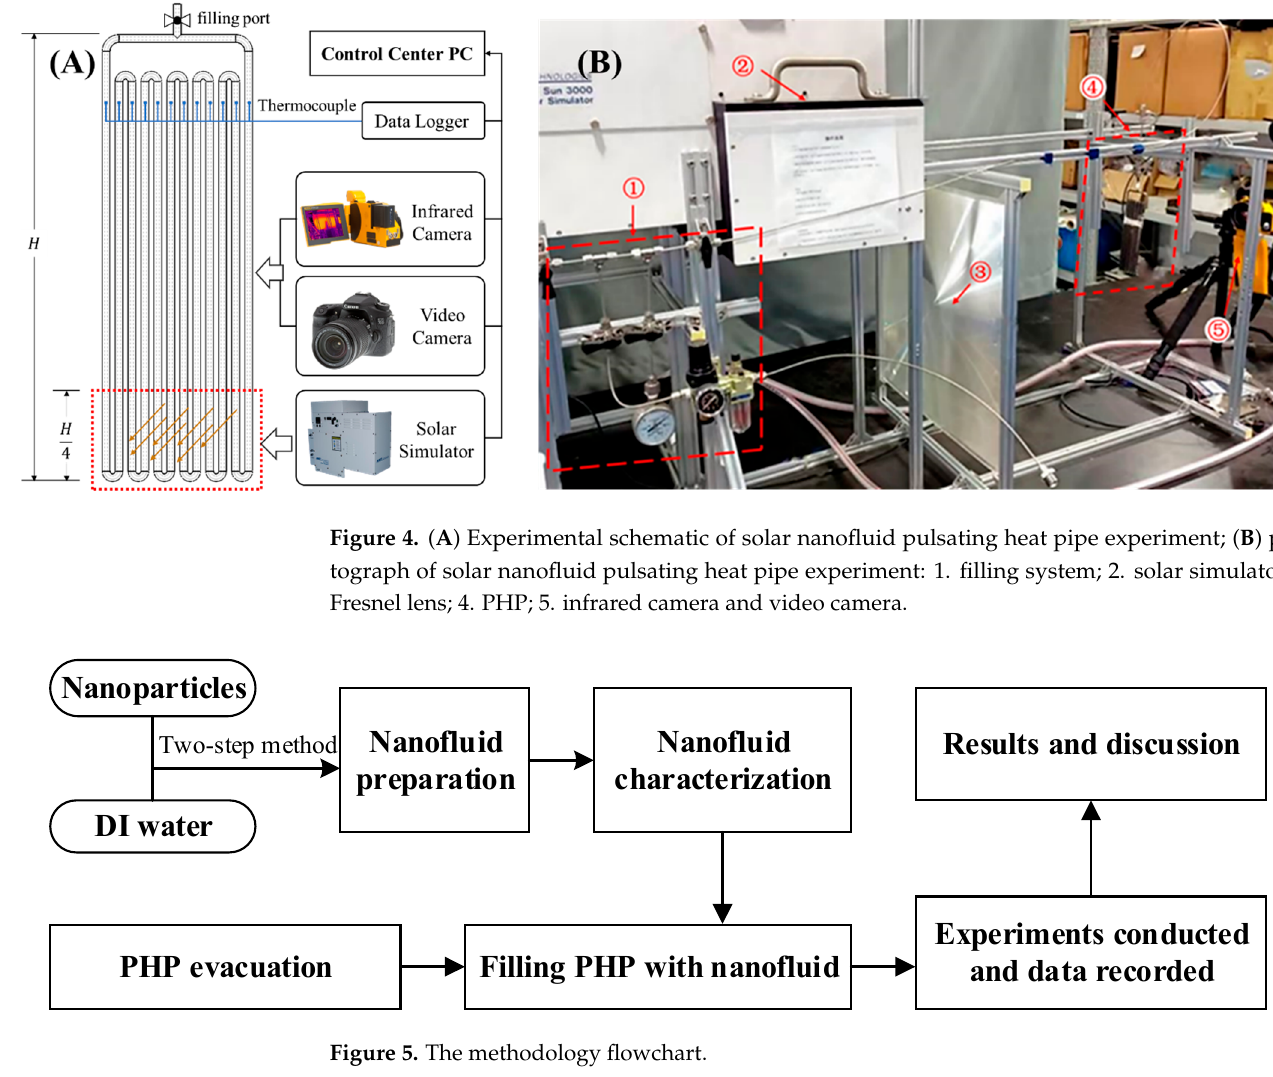
Figure 5. Each experiment is conducted twice and the deviation of temperature distribu- tion is maintained at 10%.